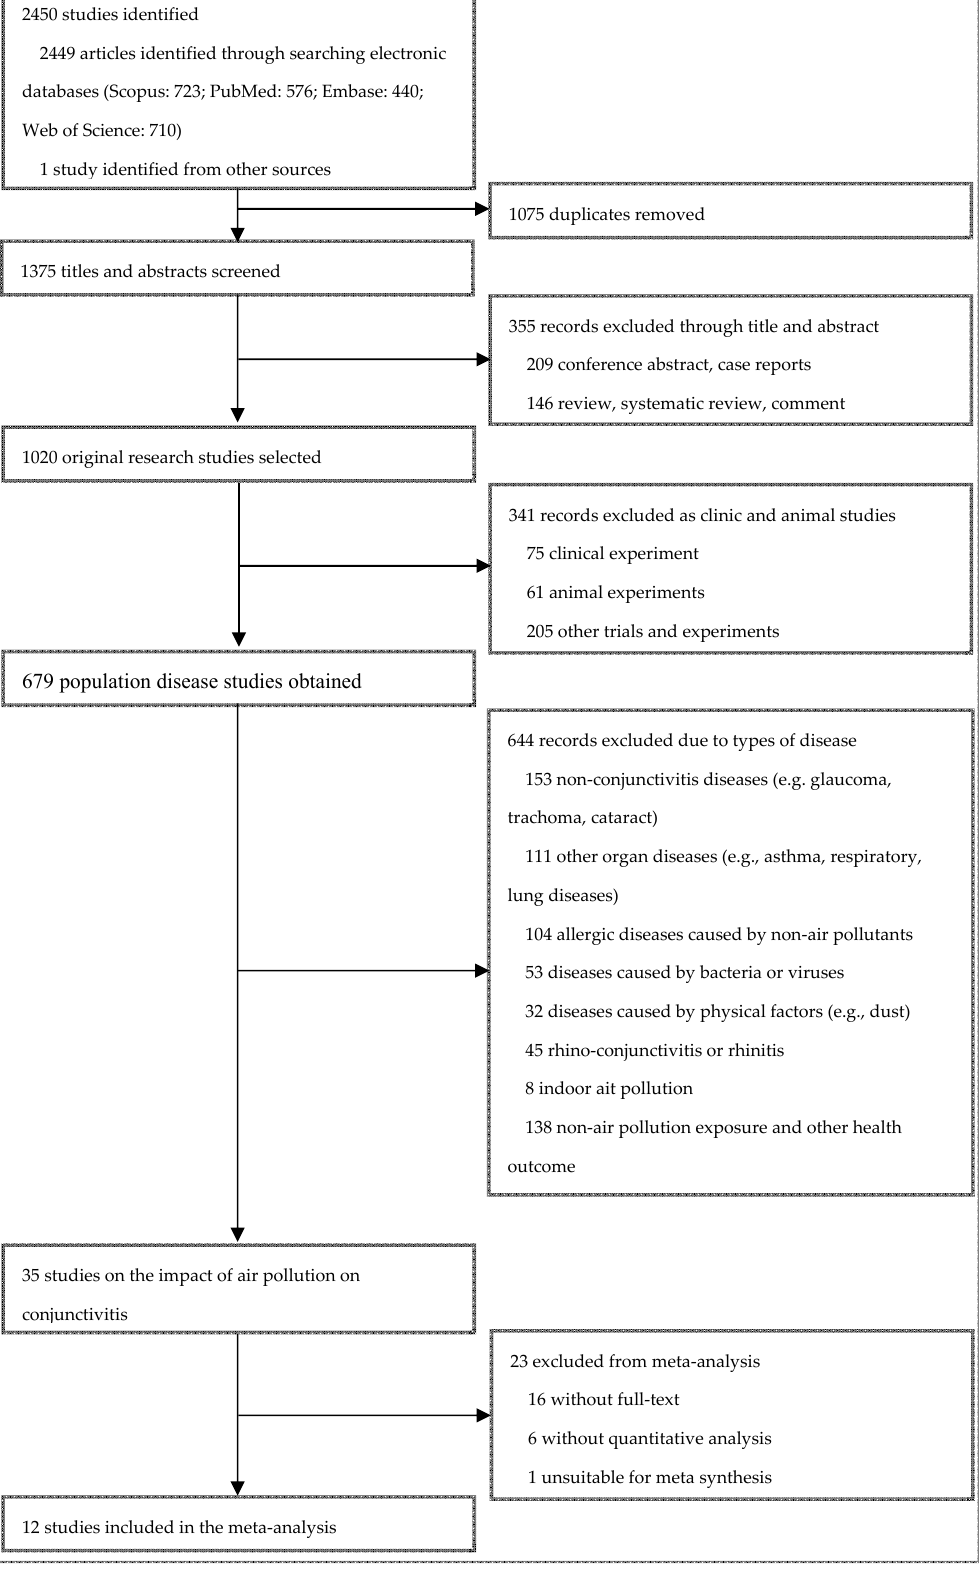
Figure 1. Flow chart for the study selection process.